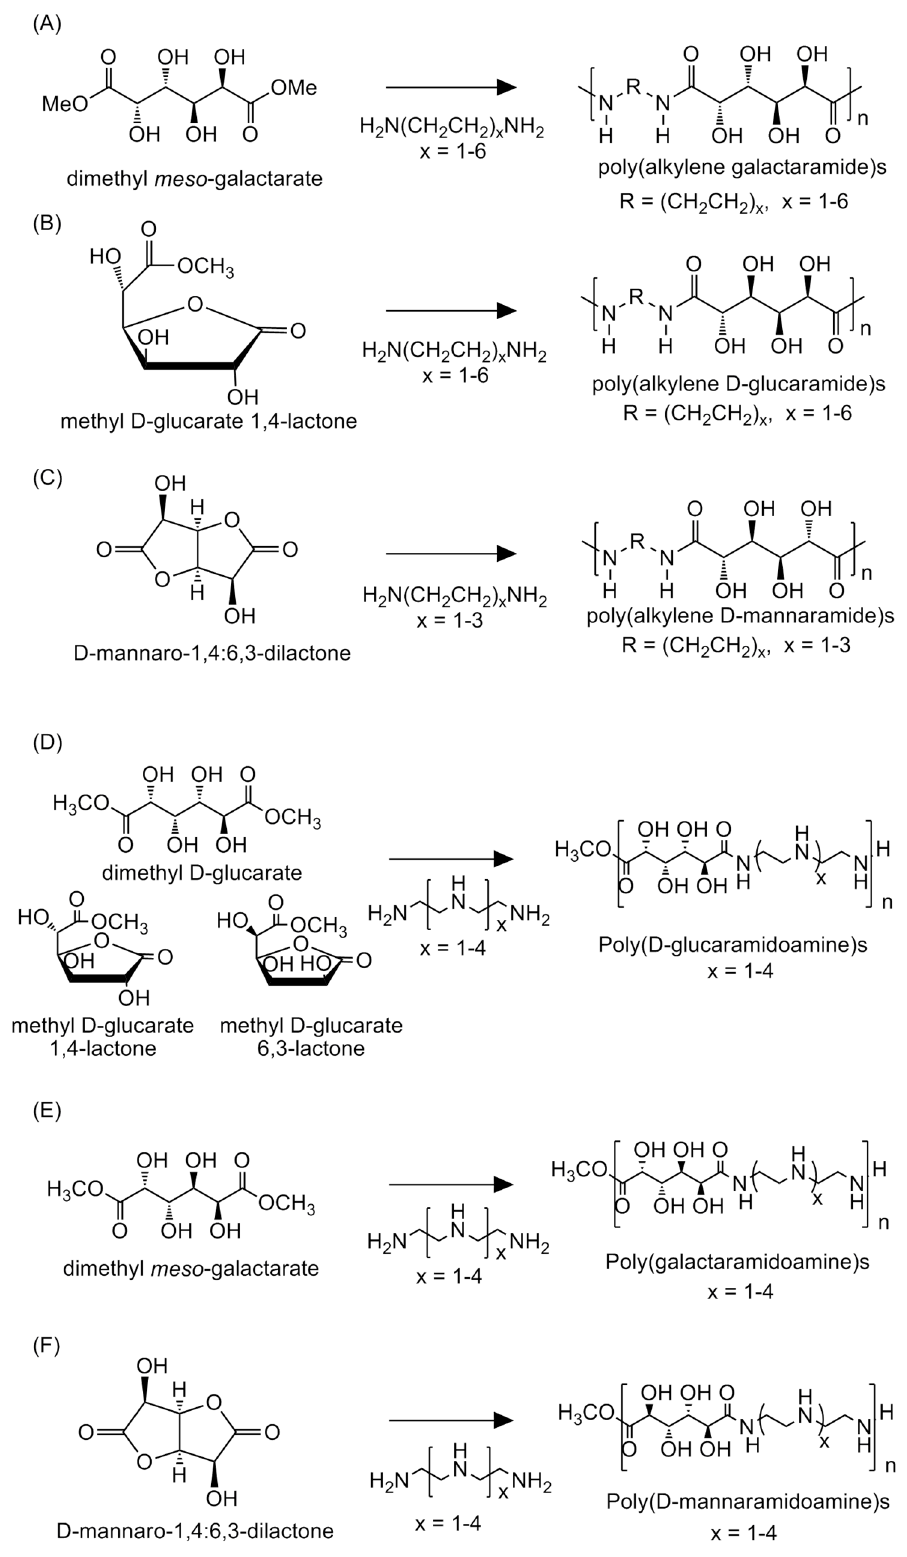
Figure 3. Schematic depiction of the syntheses of poly(alkylene galactaramide)s ( A ), poly(alkylene ᴅ -glucaramide)s ( B ), and poly(alkylene ᴅ -mannaramide)s ( C ) from their corresponding monomers and alkylenediamines [31] and the syntheses of poly( ᴅ -gulcaramidoamine)s ( D ), poly(galactaramidoamine)s ( E ), and poly( ᴅ -mannaramidoamine)s ( F ) from their corresponding monomers and secondary amines [35].